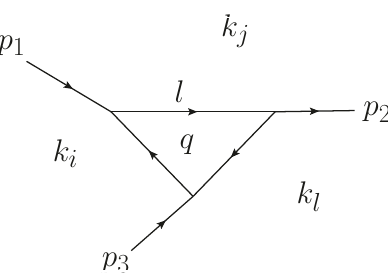
Figure 8 . An example diagram illustrating the “region momenta” assignment. The diagram divides the plane into regions; the momentum associated with the confined region enclosed by the loop is q , whereas for the regions extending to infinity it is k i . The line momenta are p i for the external lines and l for the loop momentum. The arrows denote the orientation of the line